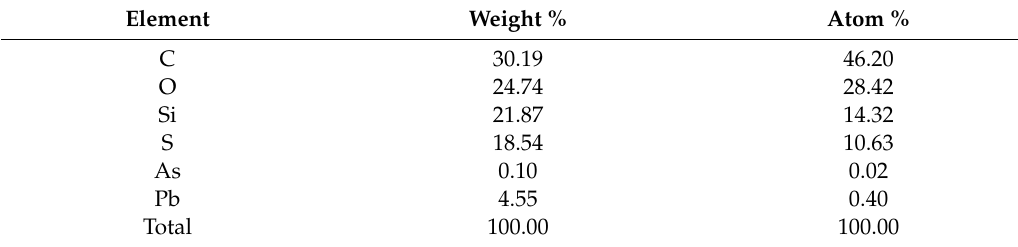
Figure 12. EDX spectrum of adsorbent 2 after adsorption. Table 3. EDX data of adsorbent 2 after